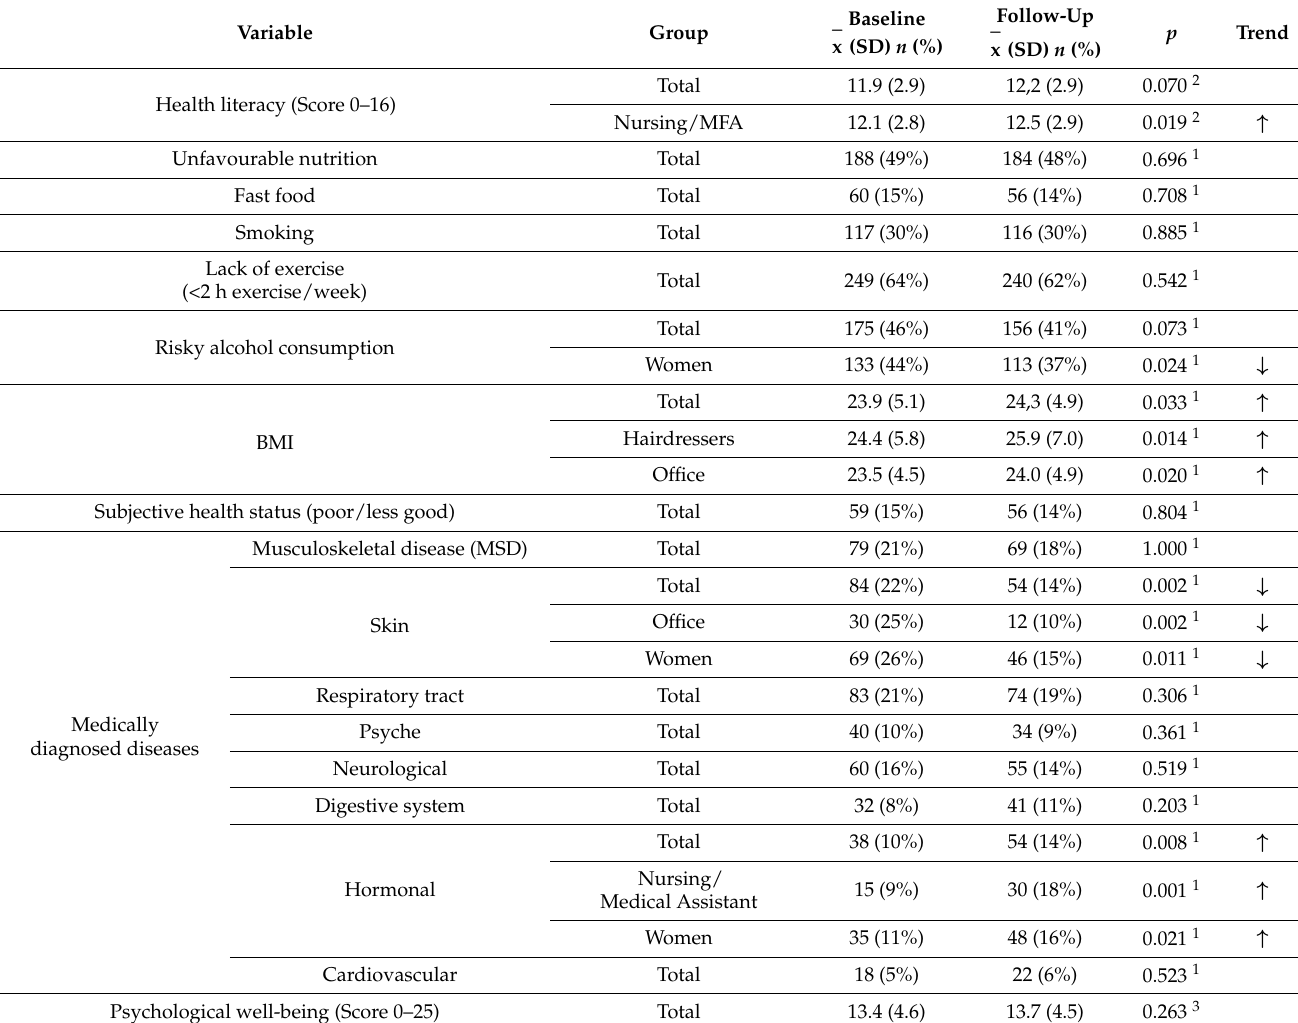
Table 3. Changes over time in HL, health behaviour and health status.